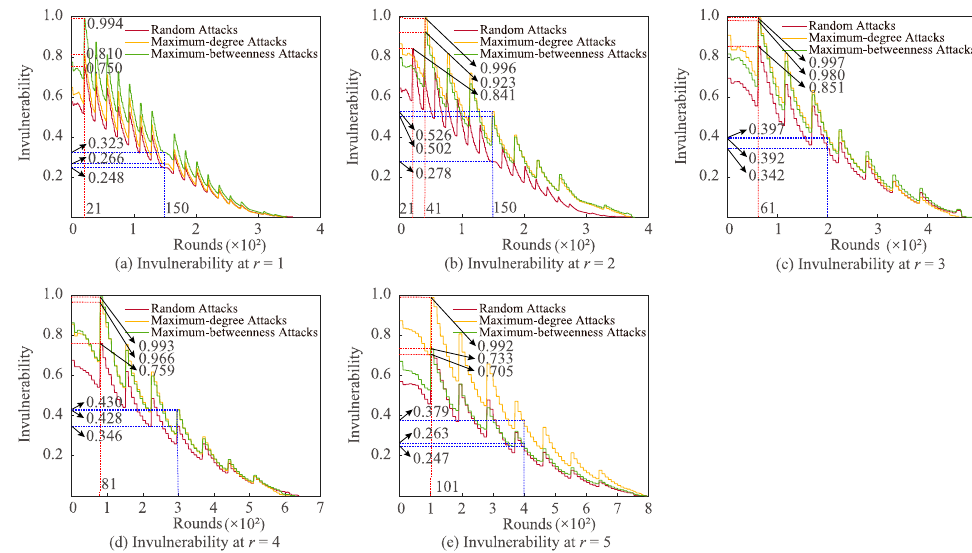
Figure 4. Impacts of altering r on invulnerability for various attacks.